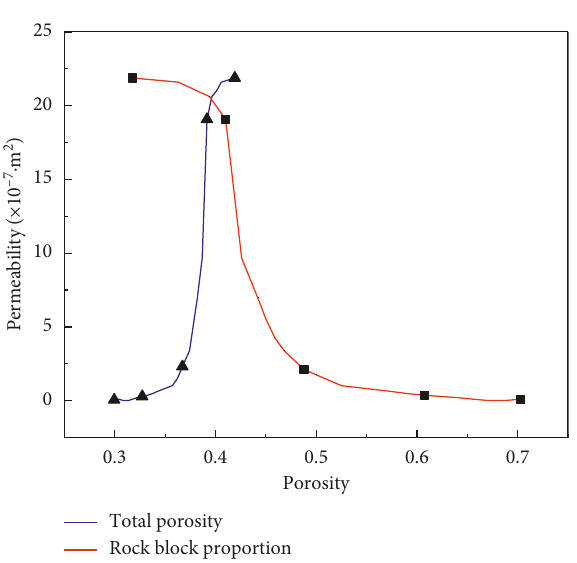
Figure 13: Permeability curve of A-6 to A-10